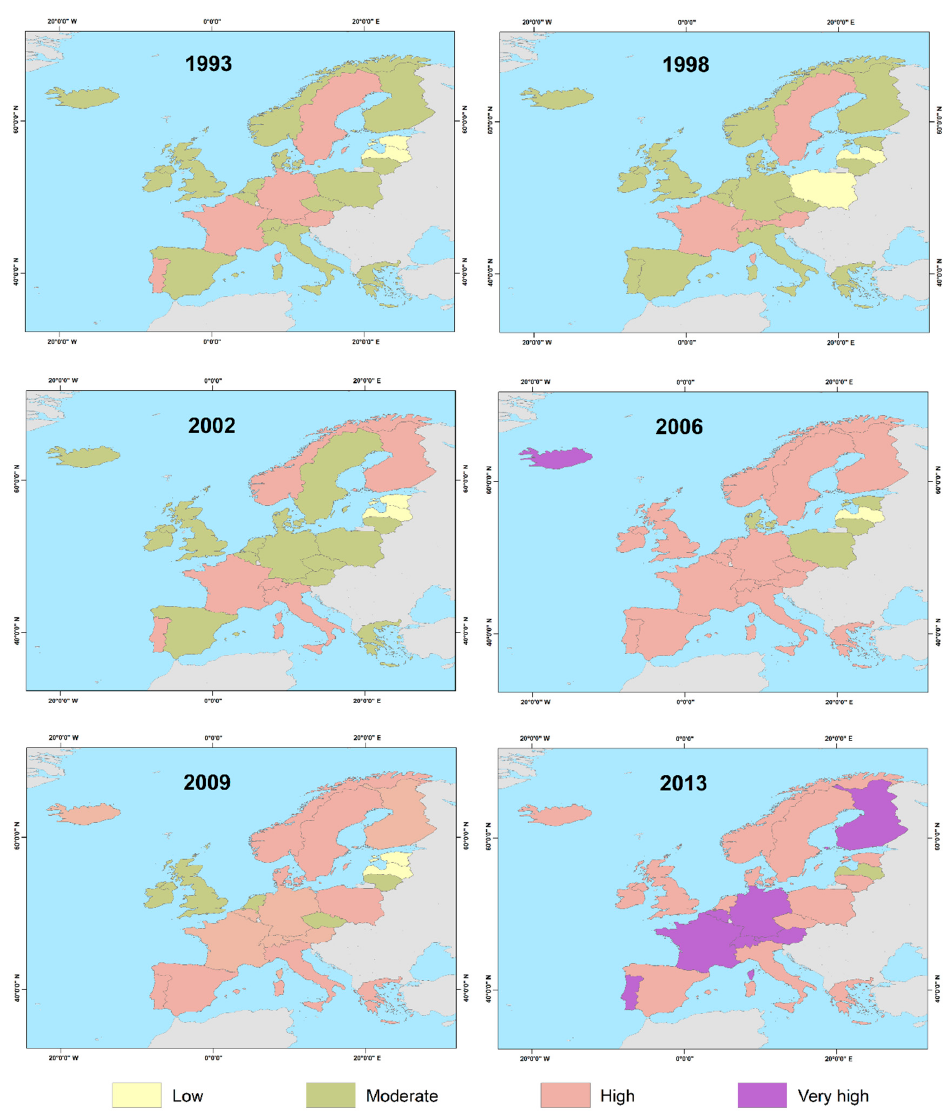
Figure 6. Population aging (parameter ξ ) for male gender in 1993, 1998, 2002, 2006, 2009, and 2013.